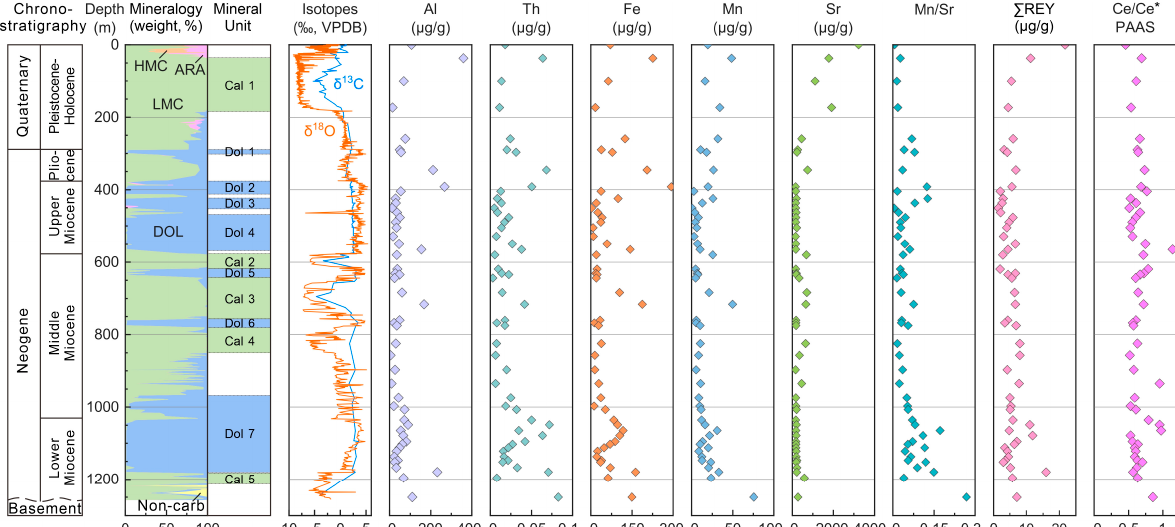
Figure 2. The stratigraphic division, mineralogical composition, and geochemical composition of the XK-1 core carbonates. The stratigraphic division scheme is from [47], mineralogical data are integrated from this study and our previous studies [22,23], and δ 13 C and δ 18 O data on the Vienna Pee Dee Belemnite (VPDB) scale are from [44–46]. ARA: aragonite, HMC: high-magnesium calcite, LMC: low-magnesium calcite, DOL: dolomite, and Non-carb: non-carbonate minerals. Cal 1–5 denote five calcite units with calcite content higher than 80%, and Dol 1–7 denote seven dolomite units with dolomite content higher than 80%. Ce/Ce* values are normalized to Post-Archean Australian